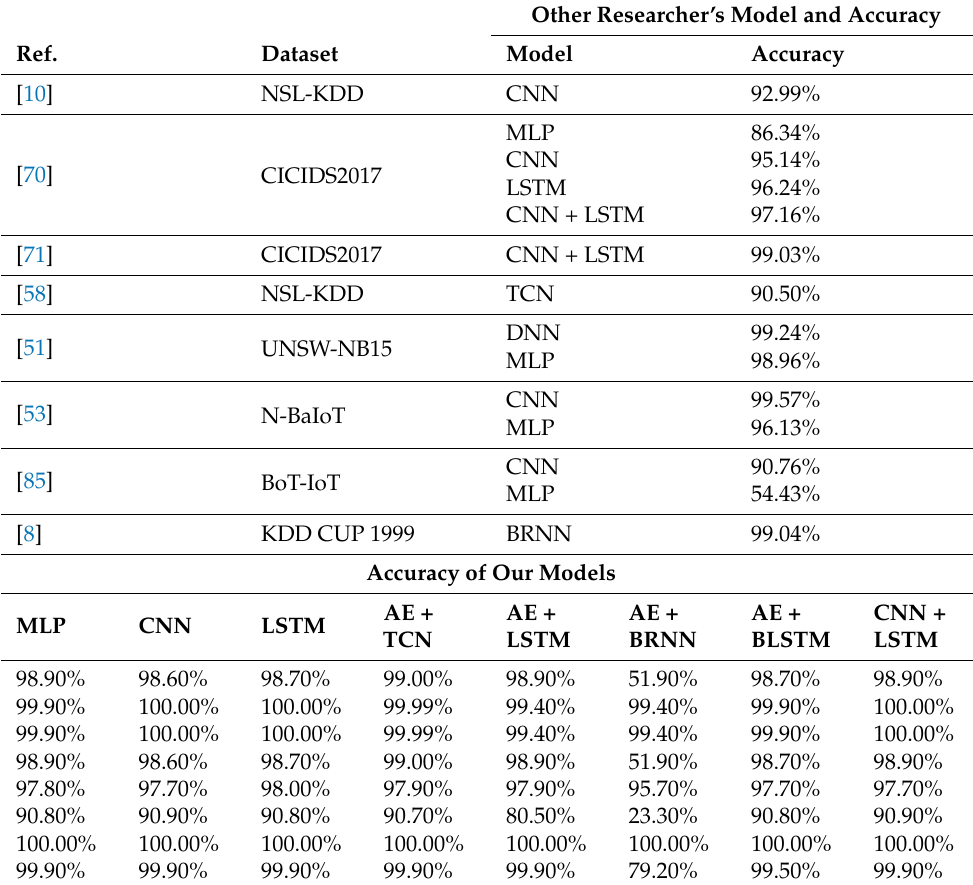
Table 7. Accuracy comparison with previous